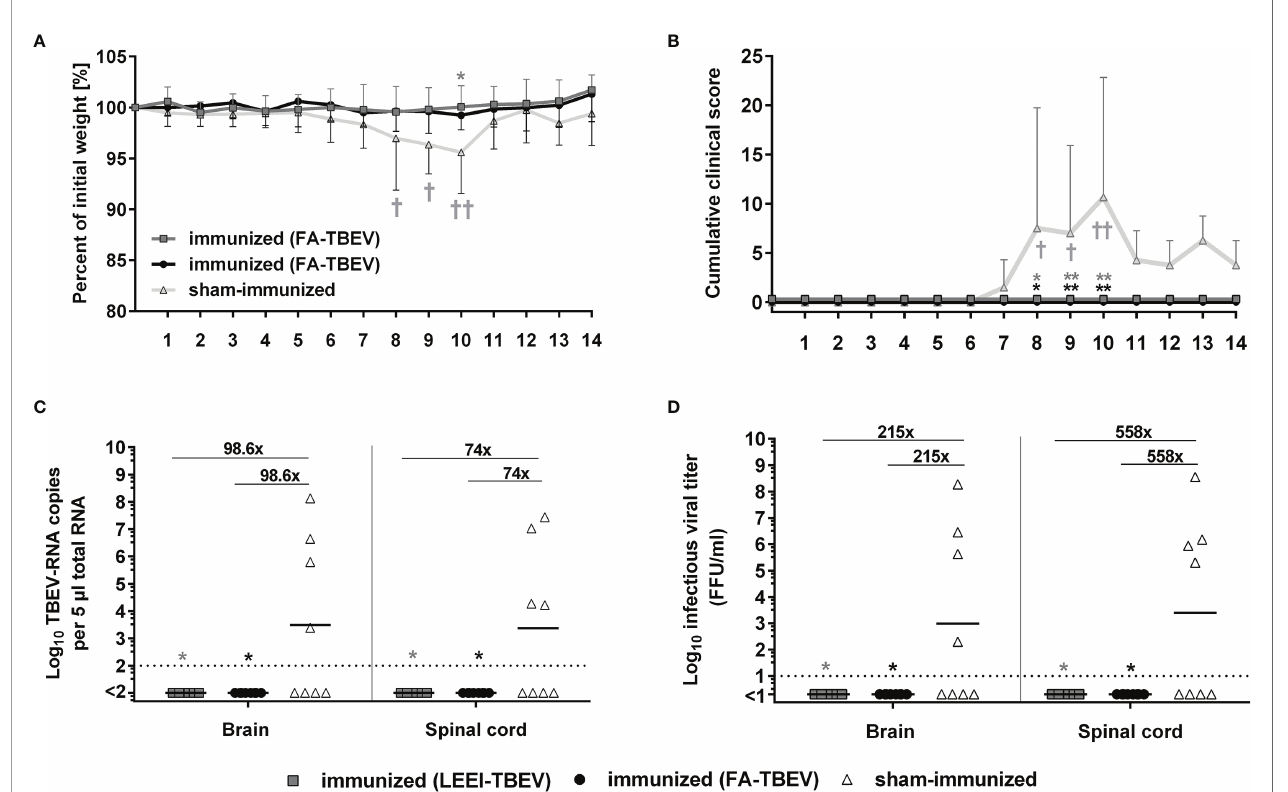
FIGURE 4 | Protective ef fi cacy of inactivated TBEV vaccines against viral-challenge in mice. Immunized mice were infected two weeks after the third immunization with active TBEV. Mice were monitored daily for 14 days post-infection for body weight (A) , and clinical score (B) . Mice were euthanized upon reaching humane endpoints (marked by a cross) or latest at day 14 post-infection. Body weight and cumulative clinical score are presented as means ± standard errors. After euthanasia, brains and spinal cords were collected and homogenized for viral RNA load analysis using RT-qPCR (C) and quanti fi cation of infectious virus by a focus- forming assay (D) . Shown are viral RNA copy numbers and infectious viral titers of individual mice, geometric means of the groups, and viral reduction compared to the sham-immunized group. Dotted lines indicate limit of detection (= 100 viral genome copies in C and 10 FFU/ml in D). Statistical evaluation of all data was performed using Kruskal-Wallis test and Dunn ’ s pairwise multiple comparison test. The analysis of weight loss and clinical score was performed for each day post- infection and the statistically signi fi cant differences are indicated at the corresponding days ( ∗ p < 0.05; ∗∗ p <